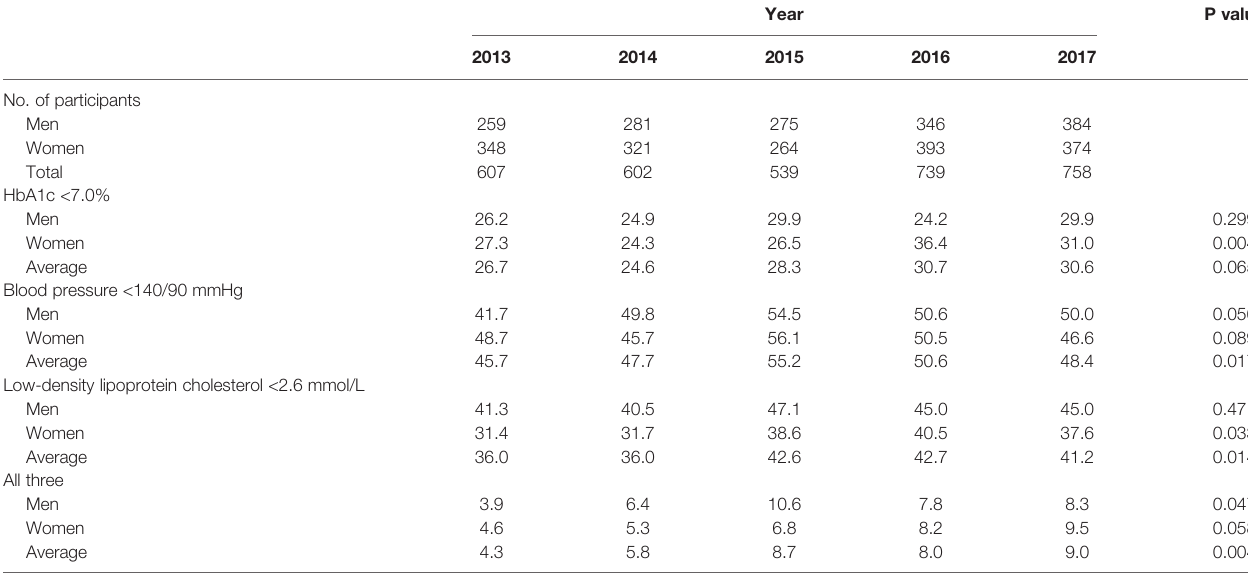
Values are adjusted for age and sex (total samples analyses only).